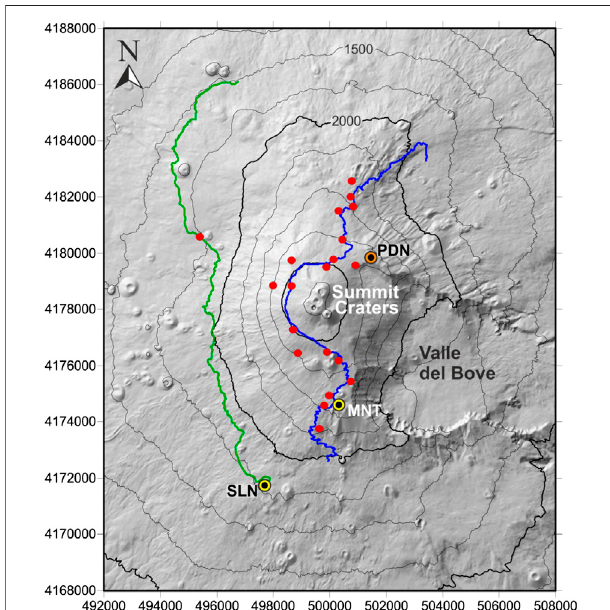
FIGURE 13 | Sketch map of Mt. Etna showing one possible con fi guration of microelectromechanical systems (MEMS) stations (red dots) selected by the optimization procedure. The position of the two stations equippedwithiGravSGsathigherelevation(SLNandMNT)andthePizzi Deneri Volcanological Observatory (PDN) is also indicated. The blue track marks the Summit road, while the green track indicates the westernmost part of the Forestale road. The position of both tracks is taken into account by the optimization procedure (see text for details).